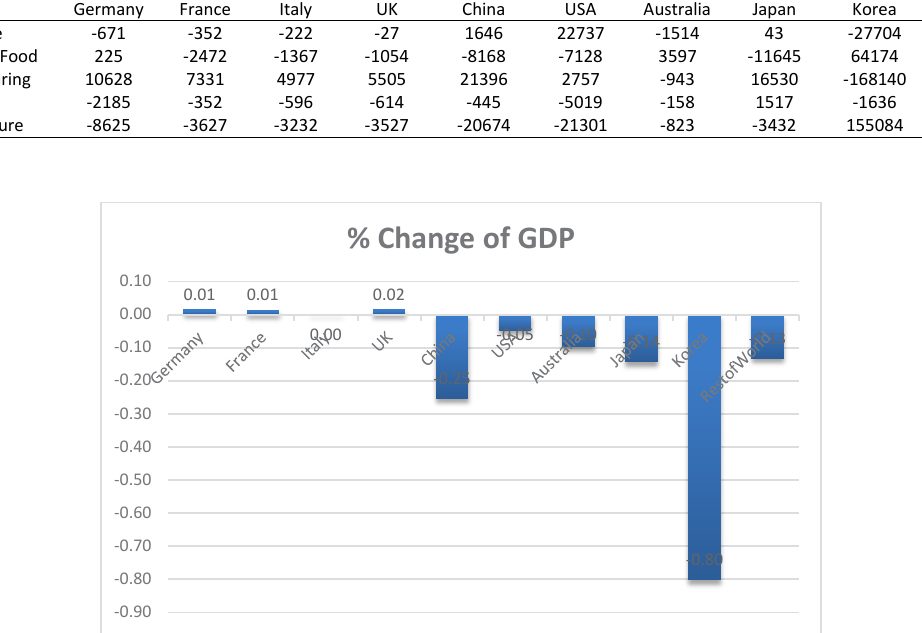
Fig. 1: Changes in gross domestic product (% Change)